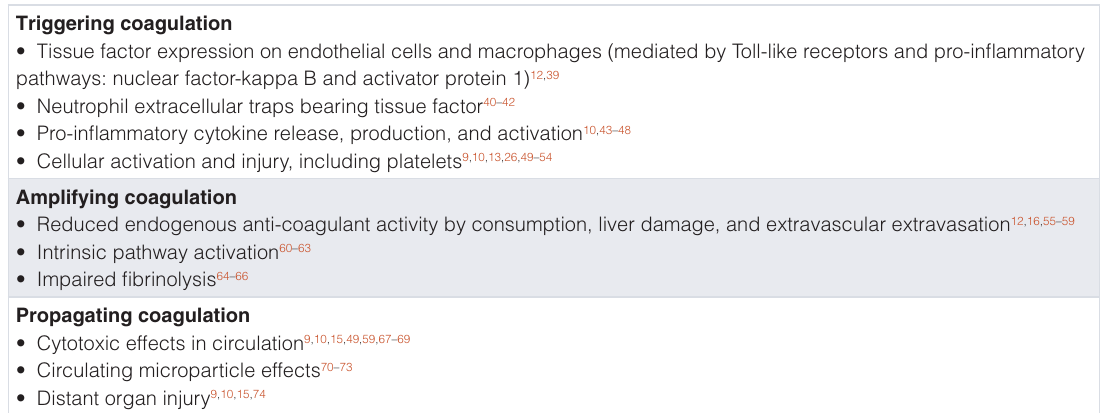
Table 1. Mechanisms by which histones and neutrophil extracellular traps cause disseminated intravascular coagulation. Triggering coagulation